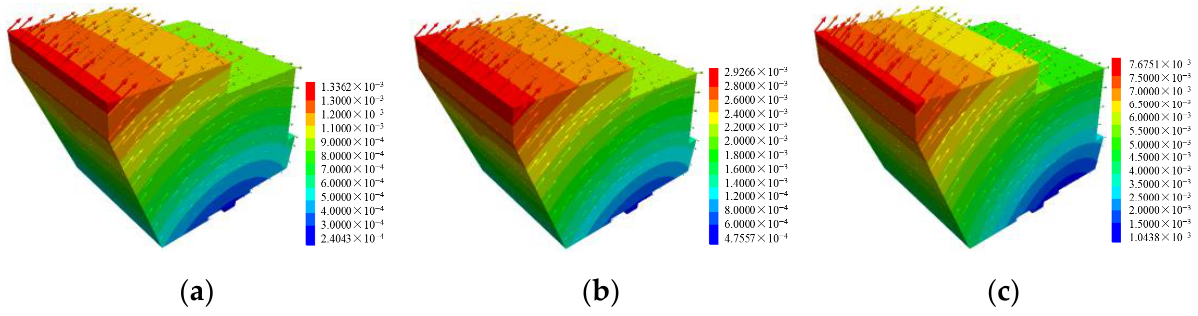
Figure 15. Variation of the displacement of the bridge anchorage with the increasing lateral thrust. (Unit in m). ( a ) 2 × design load (500 kN); ( b ) 3 × design load (750 kN); ( c ) 4 × design load (1000 kN).